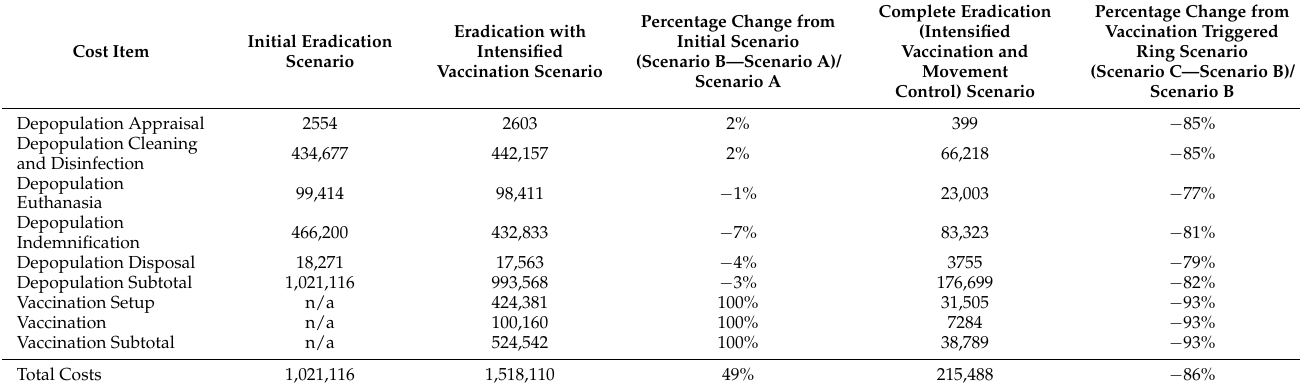
Table 3. Itemized direct government costs of eradication scenarios in